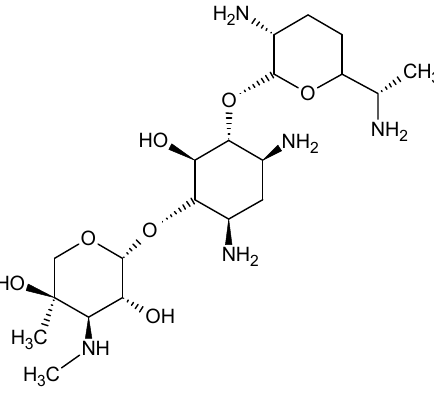
Figure 9. Structure of gentamicin.